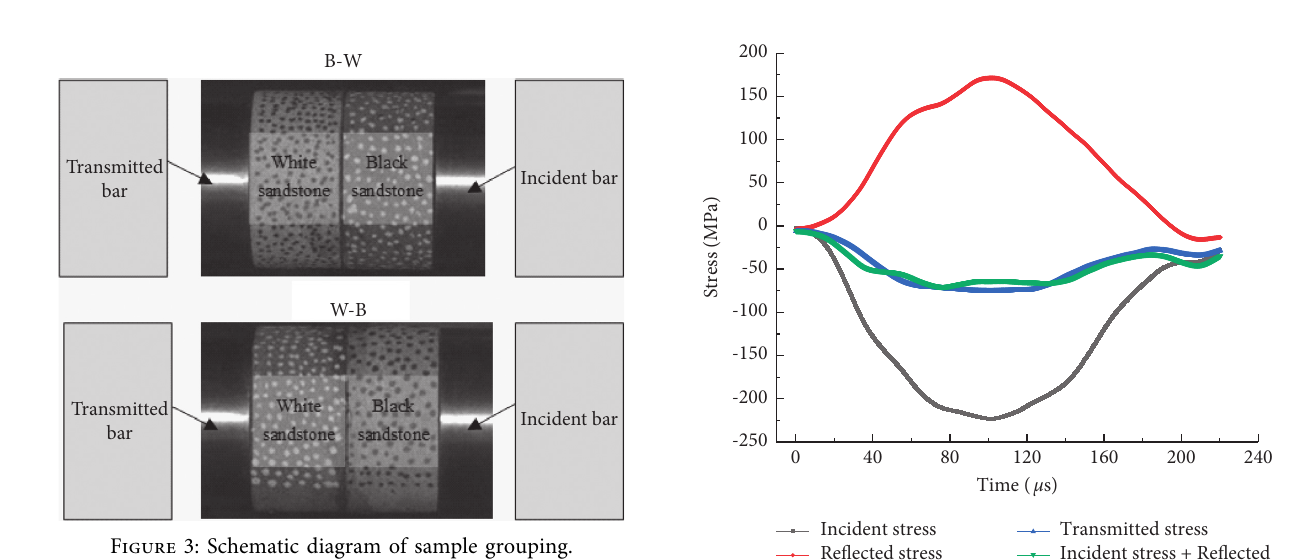
Figure 2: SHPB and high-speed photography system.